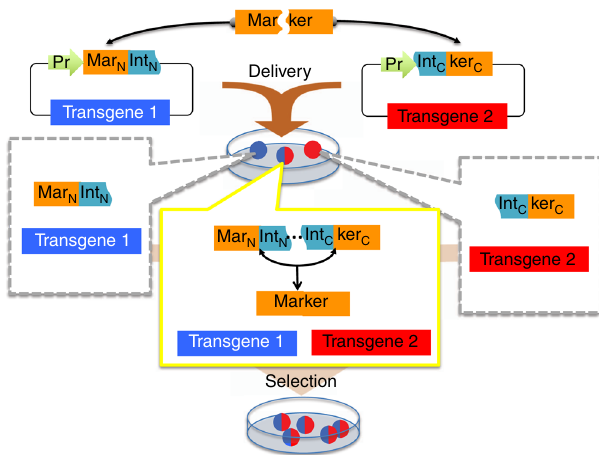
Fig. 1 Split selectable marker for co-selection of two separate transgenic vectors. The coding sequence of a selectable marker is split into an N- terminal fragment (Mar N ) and a C-terminal fragment (ker C ) and separately cloned upstream of an N-terminal fragment of a split intein (Int N ) and downstream of a C-terminal fragment of the split intein (Int C ), respectively, on two different vectors each carrying a different transgene. These vectors are delivered to cells yielding sub-populations of cells containing either one, or both of the vectors. Only cells with both vectors expressing the